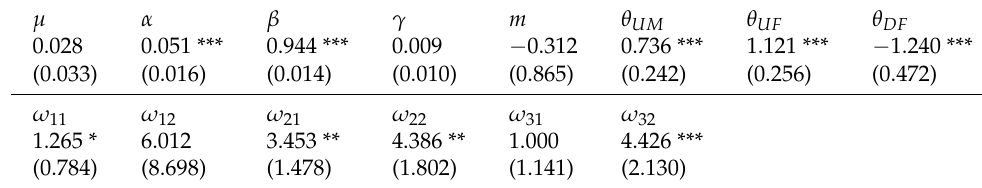
Table 3. Parameter estimates after variable